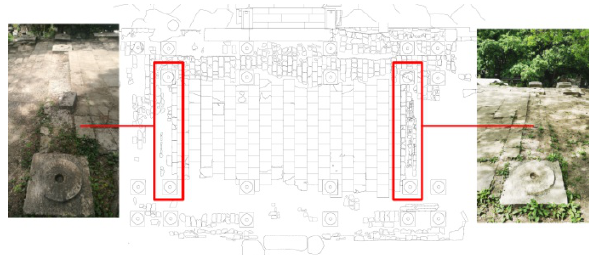
Figure 5. The location of the wall on the floor of Hanxiang Pavilion